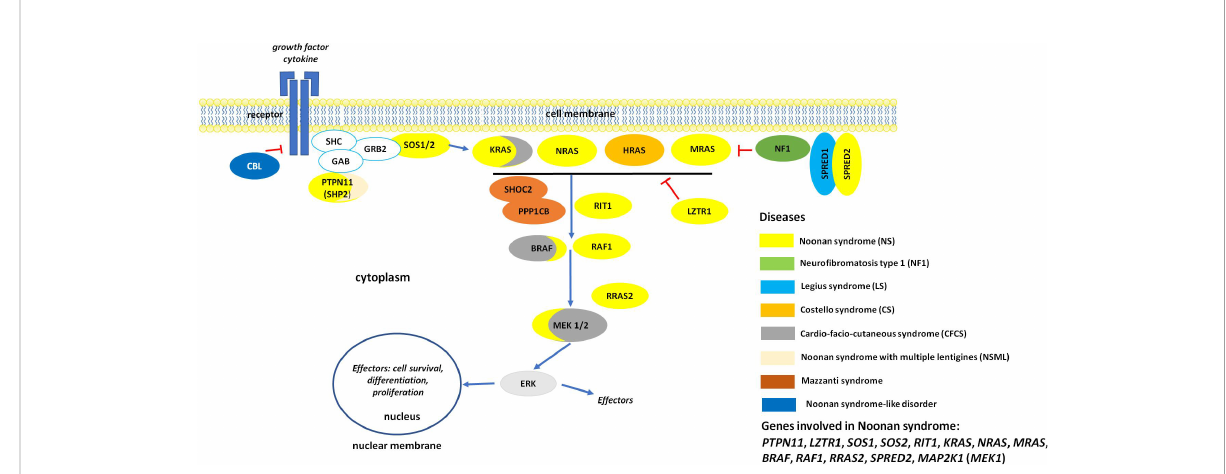
FIGURE 1 The RAS/MAPK signaling pathway and proteins involved in RASopaties. Overview of the RAS-MAPK signal transduction pathway. As shown, an extracellular stimulus triggers the activation of cell surface receptors (here a tyrosine kinase receptor, RTK), whose activation promotes the translocation of signal transducers positively controlling the function of RAS proteins (e.g., SOS1/2). These small monomeric GTPases, when activated, mediate the activation of the RAF kinases (BRAF and RAF1), which in turn phosphorylate and activate the dual-speci fi city kinases MEK1/2. Activated ERK1/2 is the last tier of the cascade and controls the function of a number of cytoplasmic and nuclear proteins. MAPK signaling is switched off by multiple circuits involving other proteins mutated in NS and related disorders ( e.g. , neuro fi bromin, CBL, LZTR1, SPRED1 and